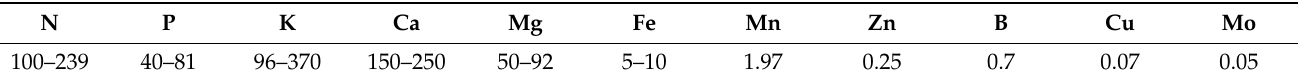
Table 1. The nutrient solution used in the control treatment (100% mineral fertilization) (mg L − 1